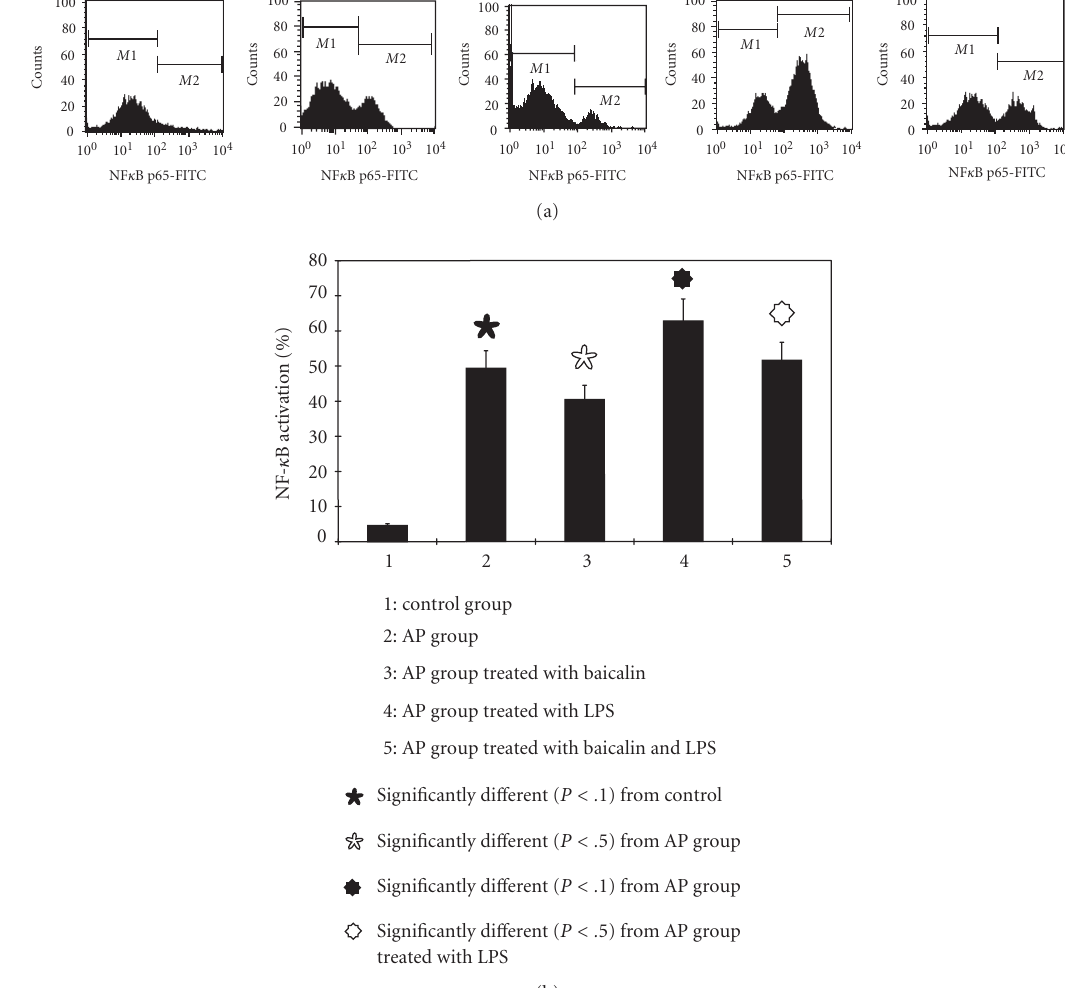
Figure 3: The NF- κ B activation detected with flow cytometry